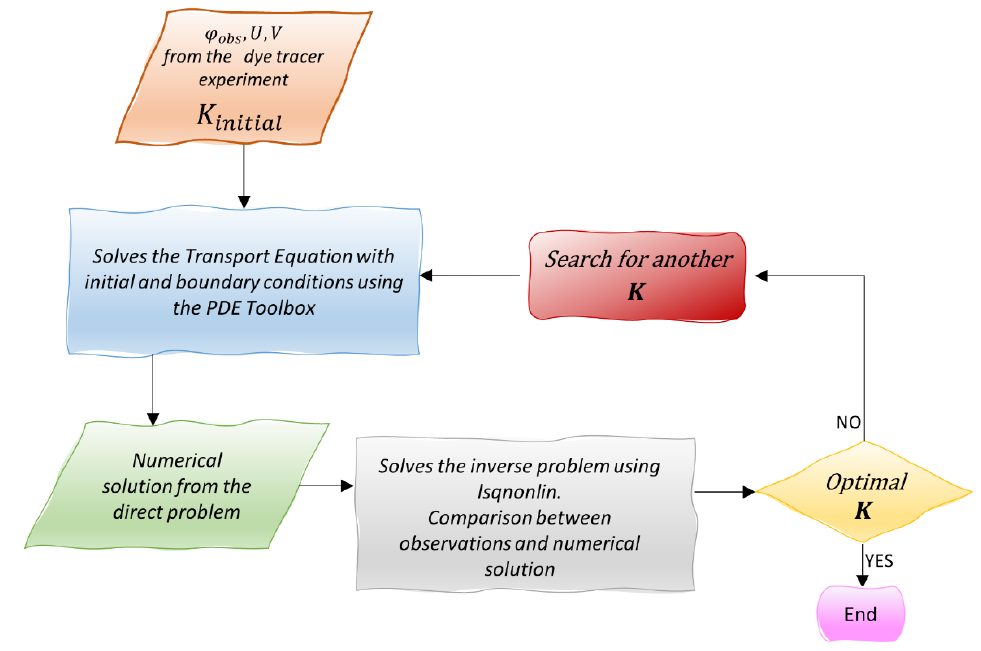
Figure 1. Flowchart of the proposed methodology to find the optimal coefficient.